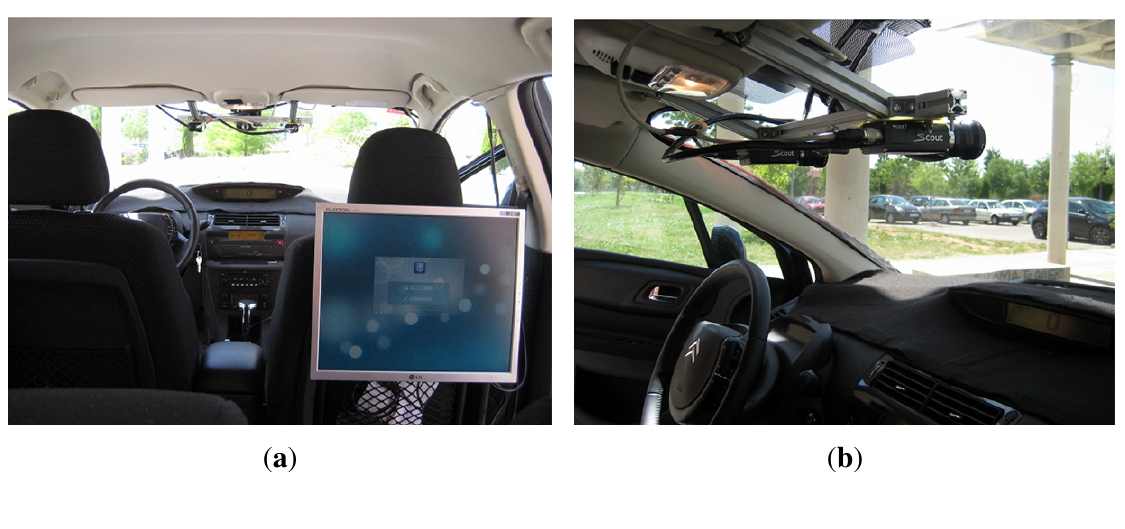
Figure 1. ( a ) Inside view of the experimental vehicle (a modified Citr¨oen C4); ( b ) Stereo vision